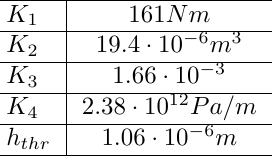
Table 2: Parameters derived from the tests. The coefficients in the torque loss model are deter- mined from the measurements by curve fitting as listed in table 2. The individual torque losses are shown in